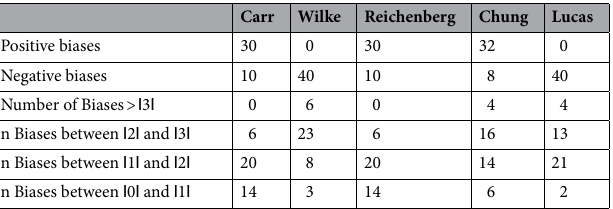
Table 5. - Biases between the flow rate corrected for the viscosity with the five selected models and the flow rate measured with the reference flowmeter.